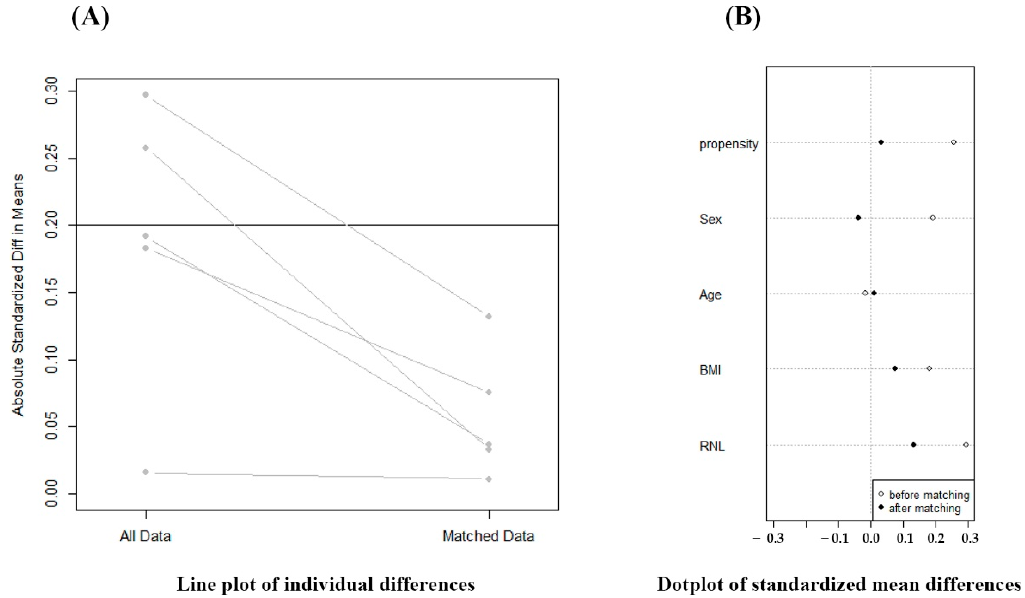
Figure 3. Evaluation of outcome of propensity score matching (PSM). PSM analysis was performed to adjust the confounding factors to reach similar baseline characteristics.